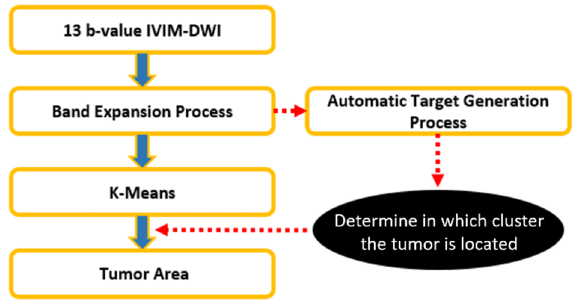
Figure 6. Flowchart of tumor detection via K-means.